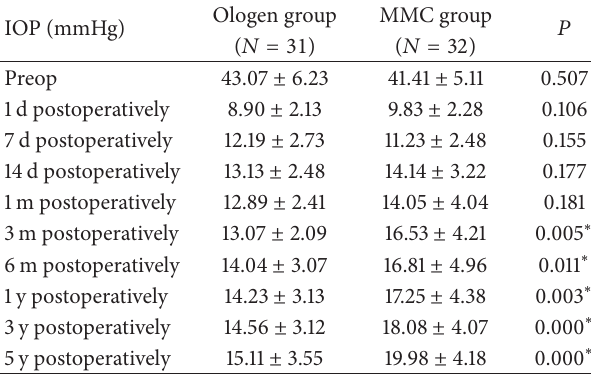
Table 2: Postoperative IOP comparison between the Ologen group and the MMC group.